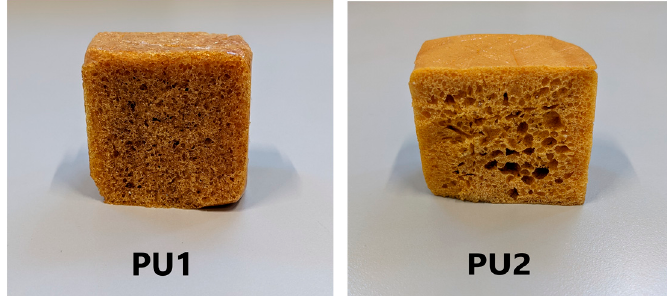
Figure 1. Polyurethane foams PU1 and PU2.